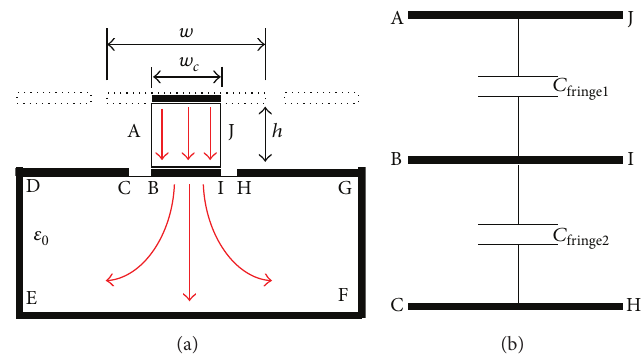
Figure 8: Model of Region III with consideration of leakage field: (a) field distributions and (b) equivalent circuit model.